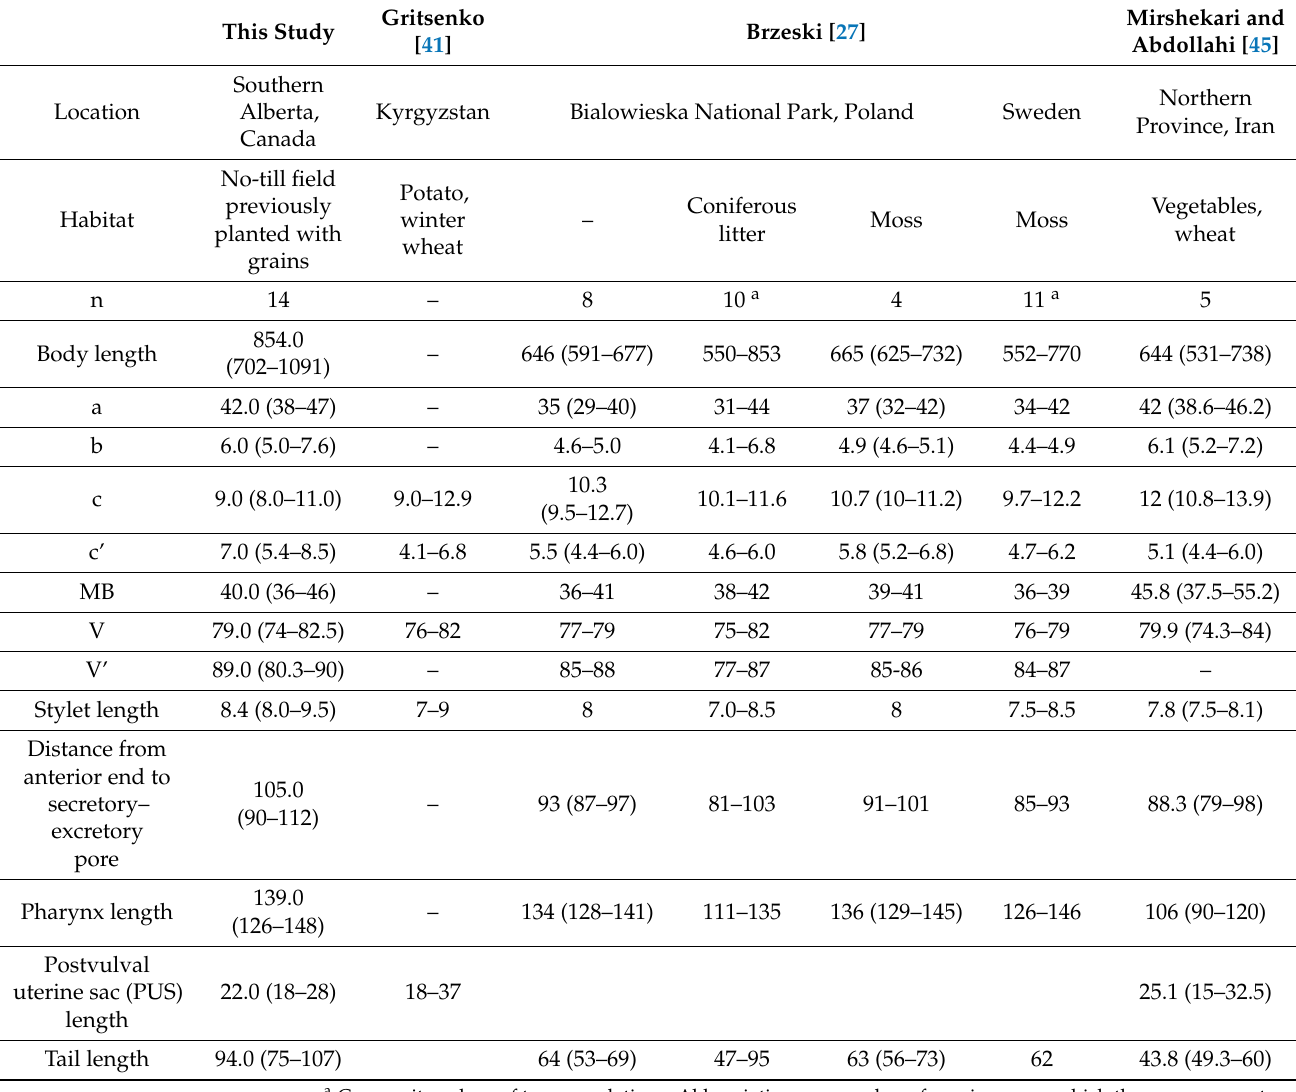
Table 4. Comparative morphometrics of all the reported populations of Ditylenchus tenuidens (female) Gritsenko [41]. All measurements are in µ m and in the form: mean (range), or range. Gritsenko This Study